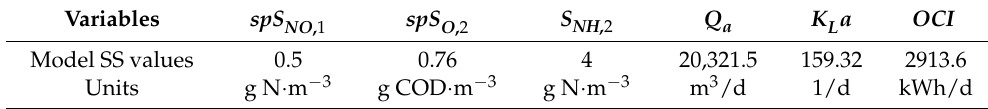
Table 4. Model steady-state optimization results.